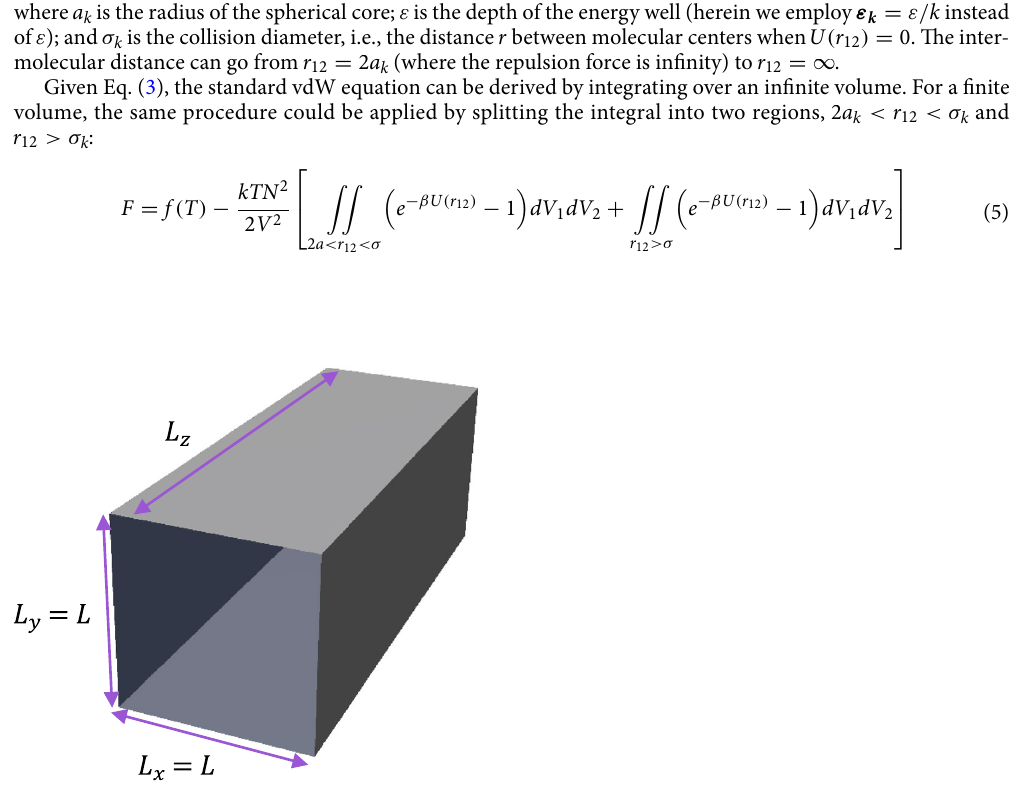
Figure 2. Schematic of a nano-scale pore in the Cartesian